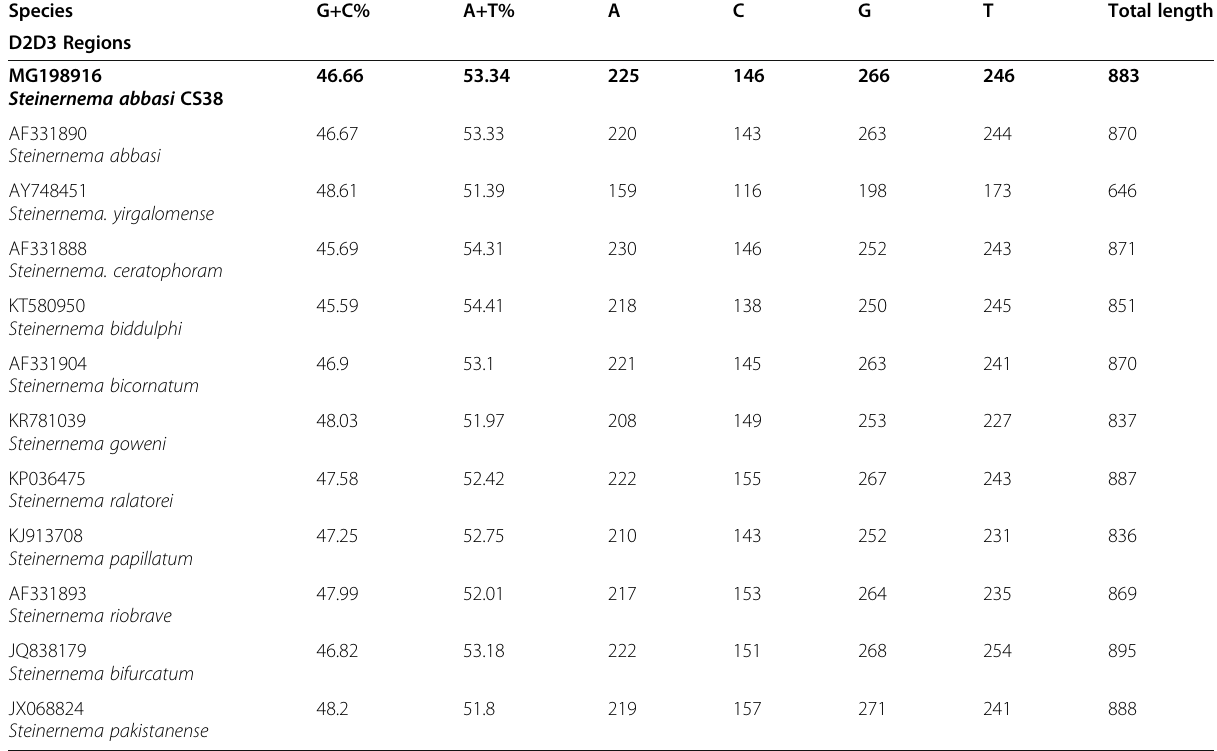
Table 5 Nucleotide composition of Steinernema abbasi isolate CS38 compared with the other known Steinernema species based on D2D3 region Species